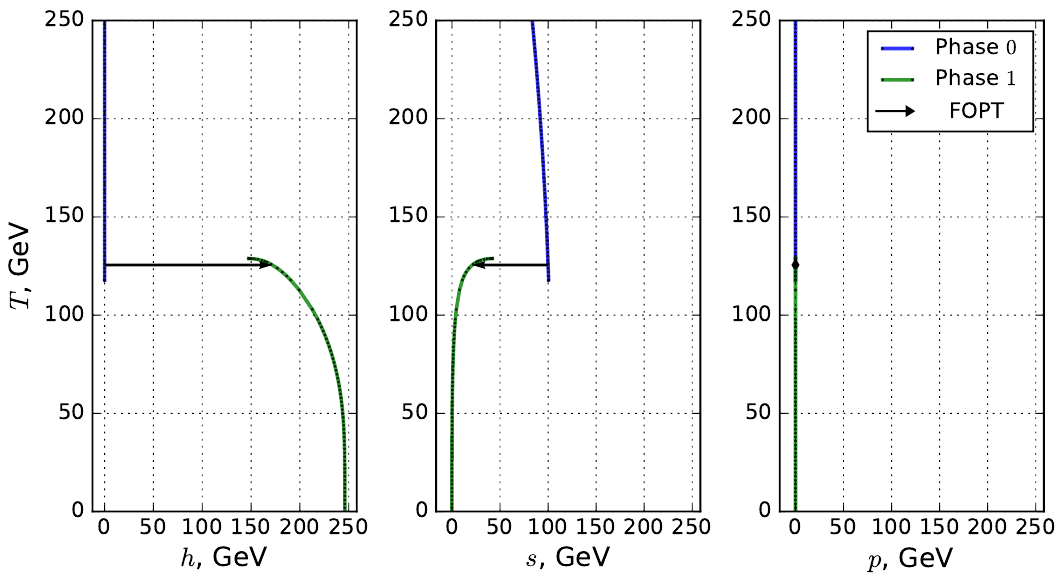
Figure 1 . Temperature dependence of field values at the minimum of the effective potential for the benchmark model Q 5 , see table 1. The full list of parameter values is given in the text. This graph is plotted using the package PhaseTracer